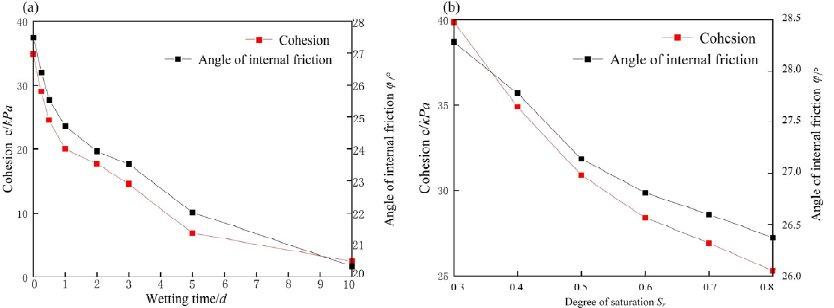
Figure 3. Effect of water-softening on the shear strength parameters of carbonaceous mudstone: ( a ) wetting duration ( S = 1.0); ( b ) degree of saturation ( t = 1 d).